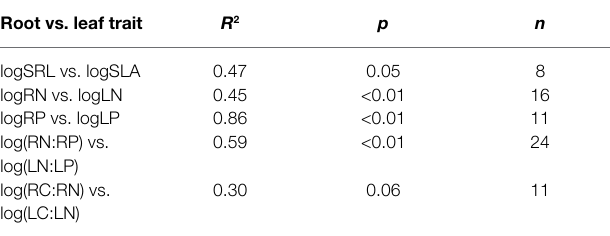
TABLE 2 | Phylogenetically-independent contrasts between leaf and fine-root traits among desert species. Root vs. leaf trait R 2 p n logSRL vs. logSLA 0.47 0.05 <0.01 16 logRP vs. logLP 0.86 <0.01 11 log(RN:RP) vs. 0.59 <0.01 24 log(LN:LP) log(RC:RN) vs. 0.30 log(LC:LN)